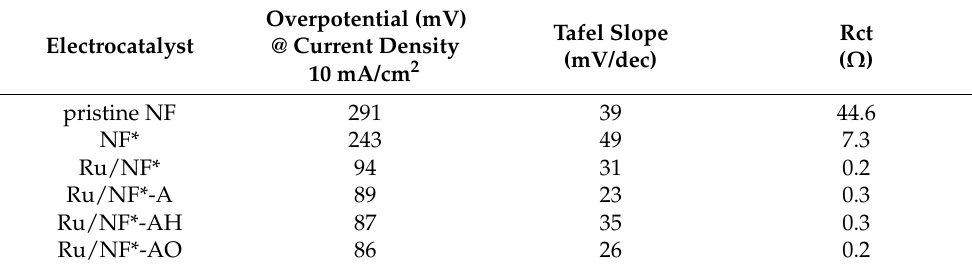
Table 4. The corresponding parameters of the electrocatalyst in 0.5 M H 2 SO 4 aqueous solution calculated from Figure